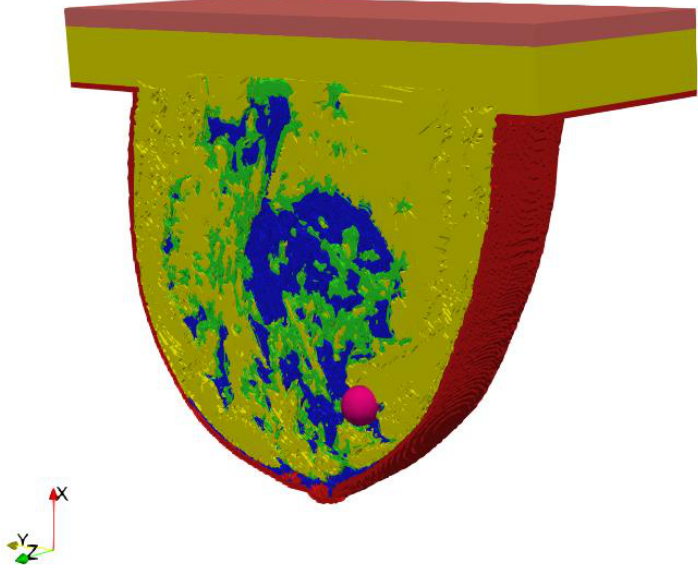
Figure 3. Axial cross-section ( z = 0) through an MRI-derived breast phantom including the main breast tissues: skin (red), fat (green), breast fat (yellow), breast gland (blue), muscle (orange), tumor (pink).